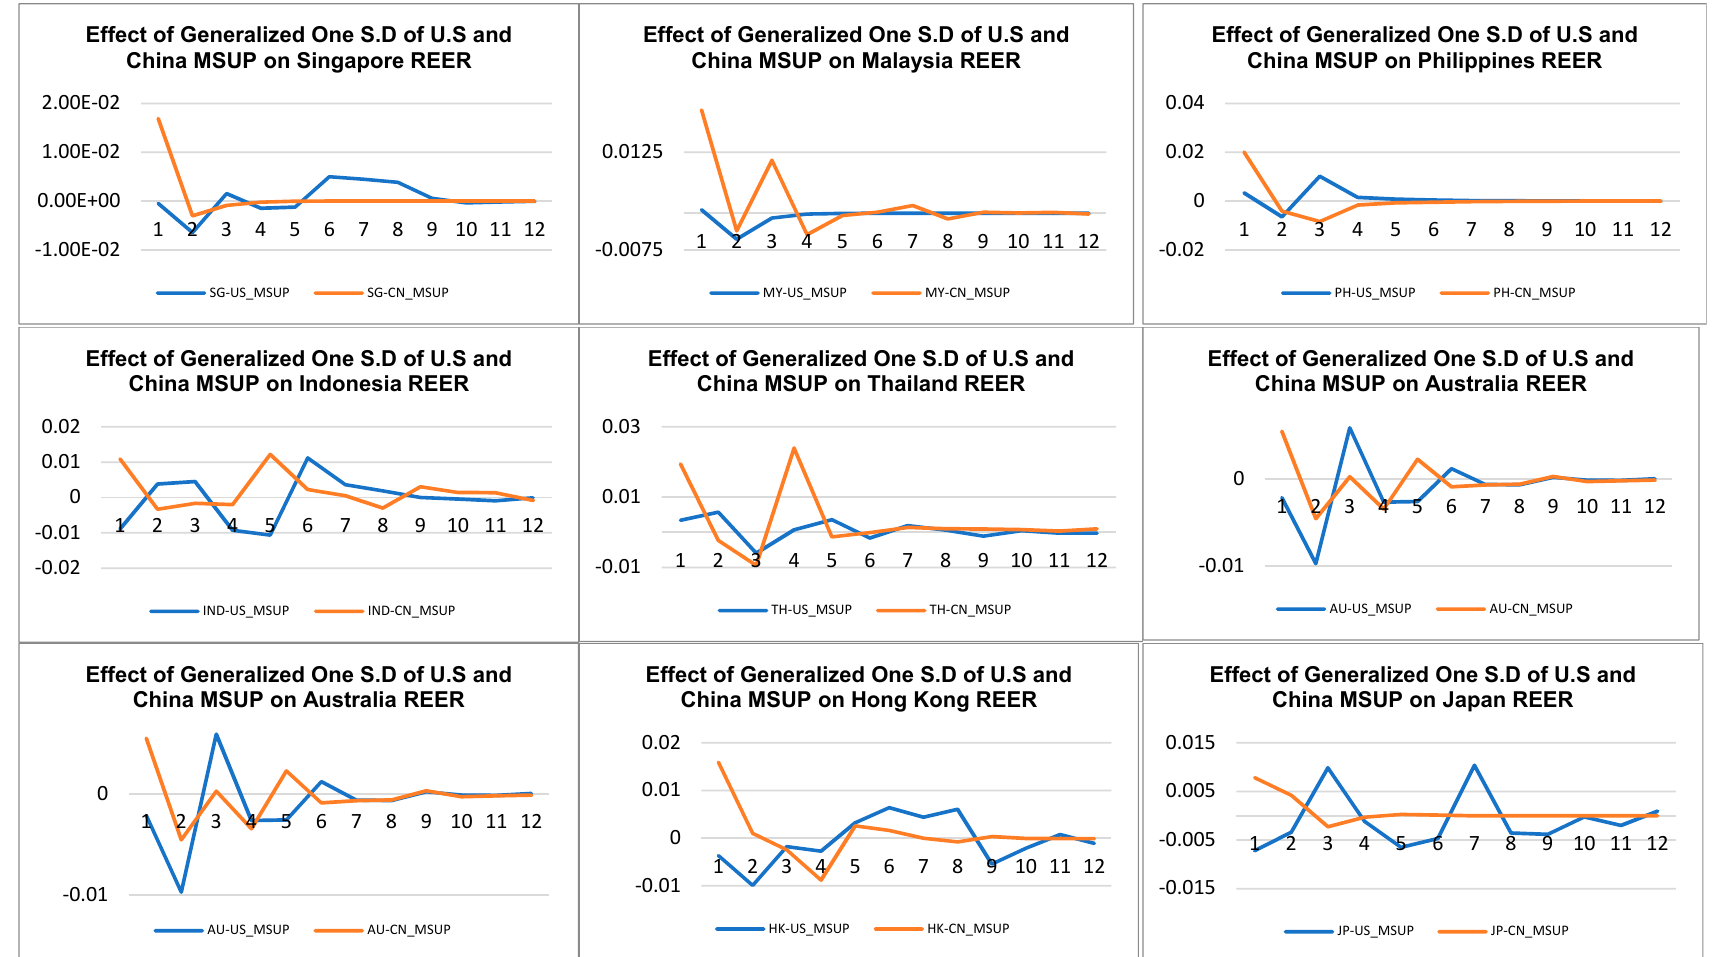
Figure 5. VAR estimations of the impact of innovations of one standard deviation in the US and China money supply aggregate (MS) on the APAC REERs.